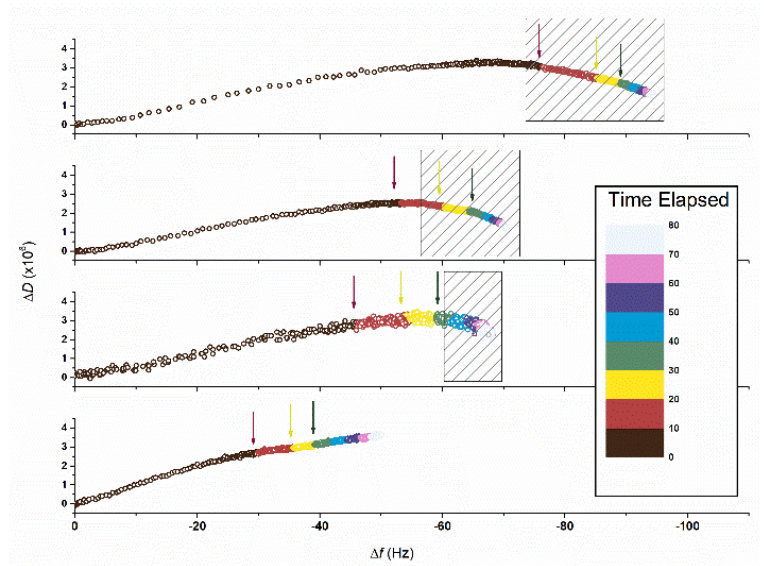
Figure 2. Df plots ( ∆ D vs. ∆ f ) showing the assembly of SbpA from different concentrations. The color map indicates the time elapsed since protein enters the chamber. Colored arrows point to the values corresponding to 10, 20, and 30 min of incubation. Dashed boxes approximatively highlight the region after the transition peak. Such a region corresponds to negative slopes from the Df plot, due to hardening of the film as more mass is incorporated.